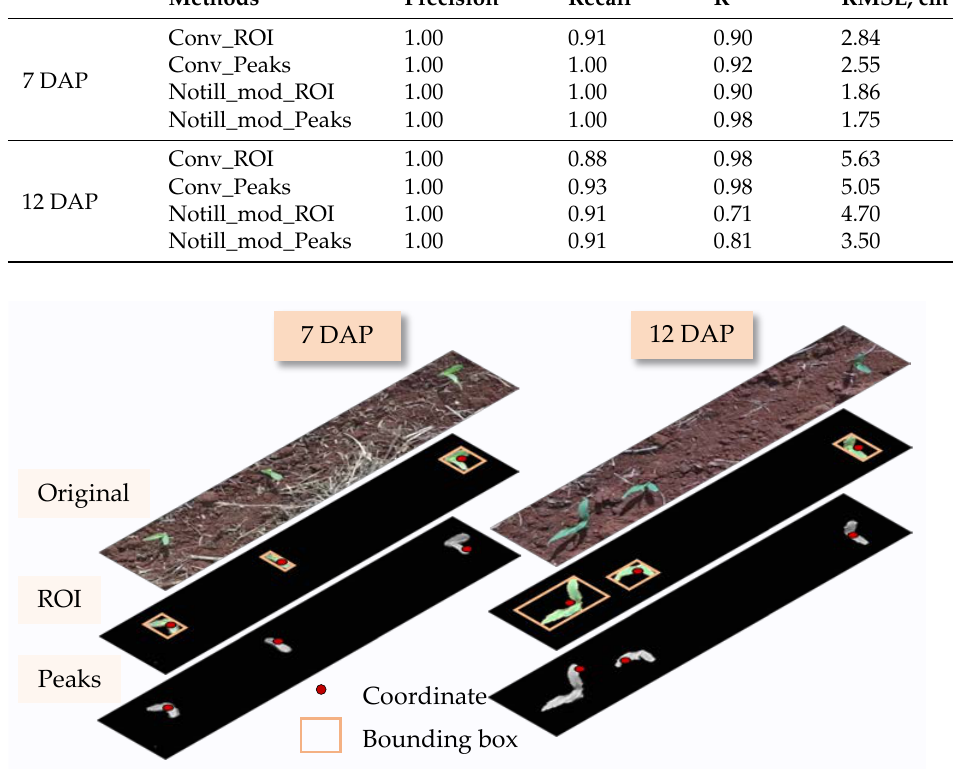
Table 2. Descriptive statistics, specific planting metrics, and CV in all scenarios. Methods